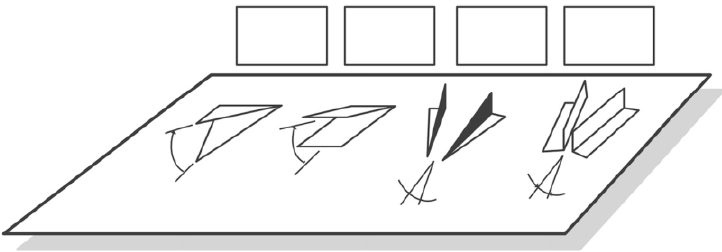
Figure 17: Different kinds of vortex generators: delta wing, rectangular wing, delta winglet pair and rectangular winglet pair [25].